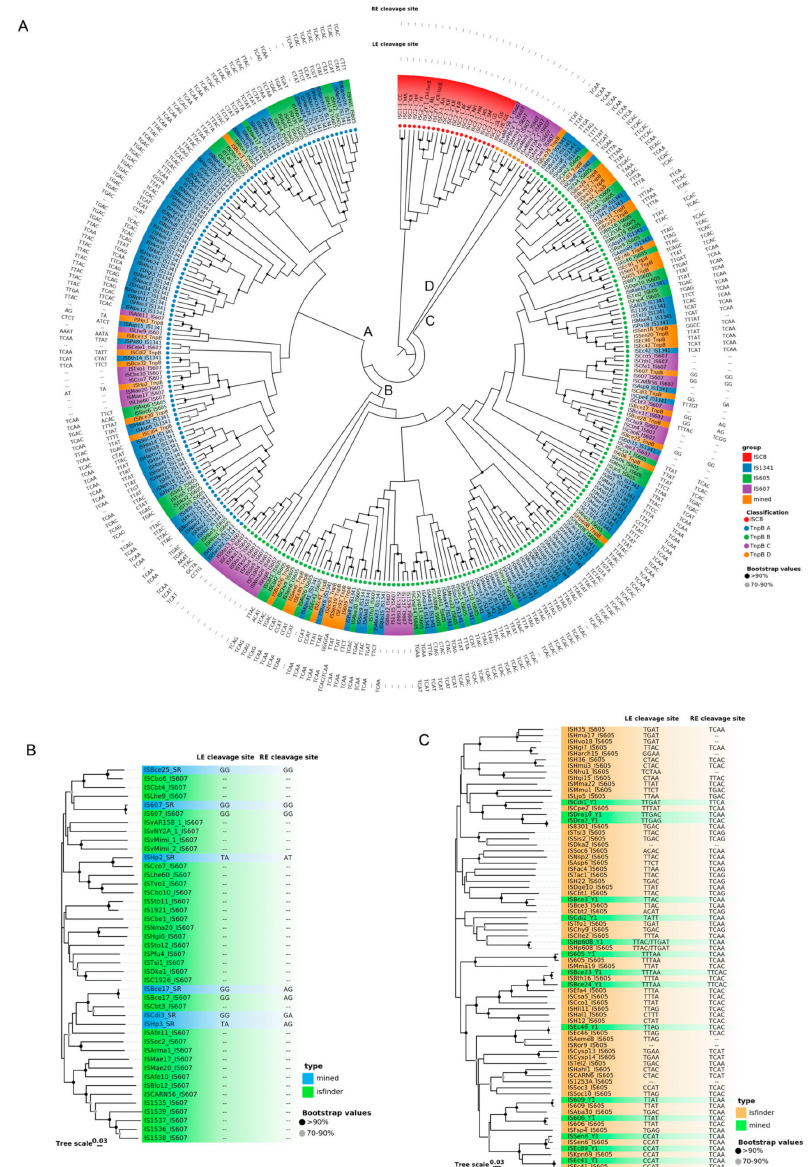
Figure 3. The phylogenetic tree of SR, Y1, and TnpB. The bootstrap values are indicated with a black circle (>90%) and a grey circle (70–90%). ( A ) The phylogenetic tree of TnpB and IscB. The TnpB proteins are classified into two main branches (TnpB-A and TnpB-B) and two minor branches (TnpB-C and TnpB-D), are indicated with blue, green, purple, and orange circles, respectively. The IscB formed a single branch shown with red circles. The mined TnpBs from six species are also shown in orange background. The IS1341 subgroup is shown in blue background. The IS605 subgroup is shown in green background. The IS607 family is shown with purple background. ( B ) The phylogenetic tree of SR. The SR proteins from ISfinder are shown in green background. The mined SR proteins are shown in blue background. ( C ) The phylogenetic tree of Y1. The Y1 proteins from ISfinder are shown in orange. The mined-Y1 proteins are shown in